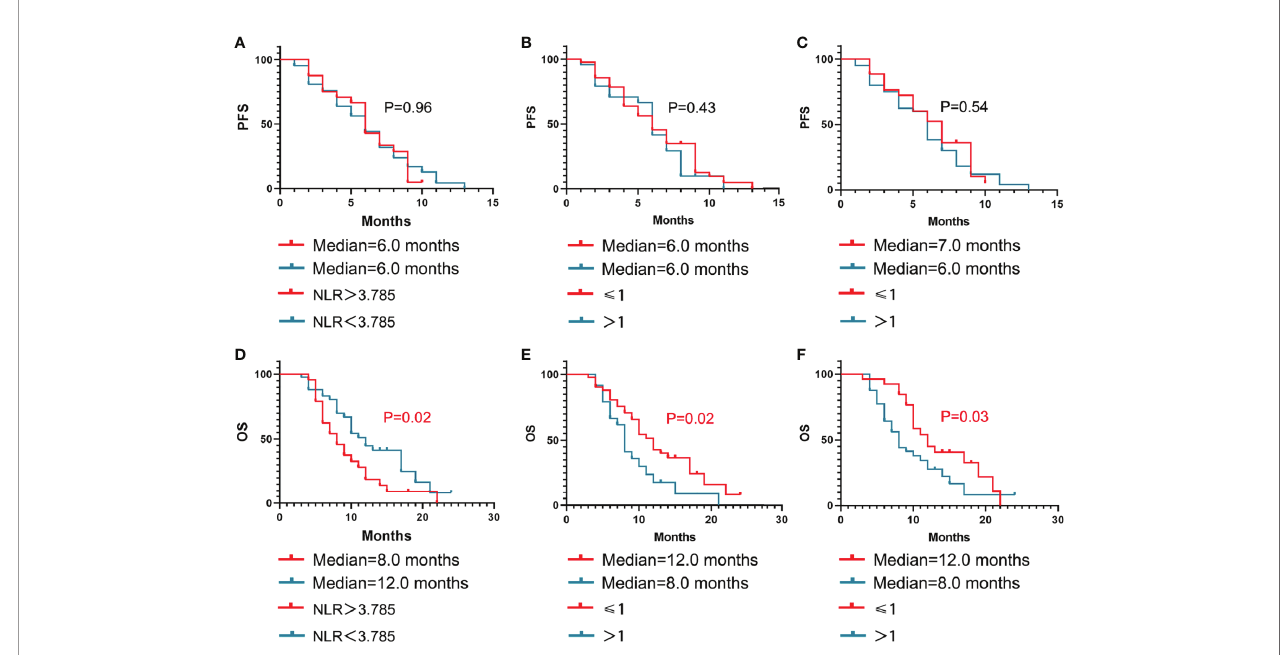
FIGURE 2 | Kaplan – Meier estimates of PFS and OS with different in fl uencing factors. NLR (A, D) , number of organs involved in the primary recurrence (B, E) , and number of organs involved before apatinib treatment (C, F) .